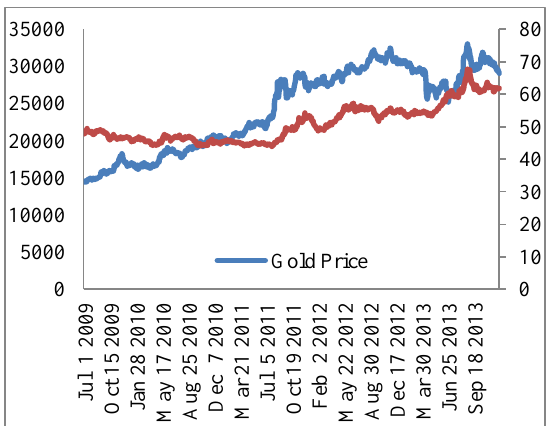
Fig. 2 The Exchange Rate of US Dollar to INR and Gold